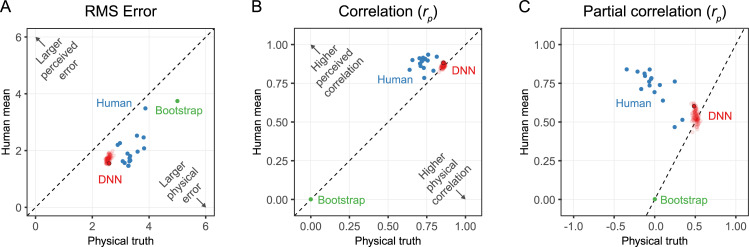
(A) Root Mean Square error of individual observers (blue), individually trained DNN networks where the final network has a black outline (red), and the green dot shows a bootstrapped estimate of random performance based on 1000 random draws. If data points are in the bottom half of the plot the error is larger for the physical truth than the human mean or perceived viscosity. (B) Same type of plot showing the Pearson correlation instead of RMSE. Partial correlations are performed with the human mean where the physical truth was the controlling variable. If data points are in the bottom half of the plot the correlation is larger with the physical truth than the human mean or perceived viscosity. (C) Same plot as B only with partial correlations where for the human mean the physical truth is a control variable and for the physical truth the human mean is a control variable, showing the independent correlations.